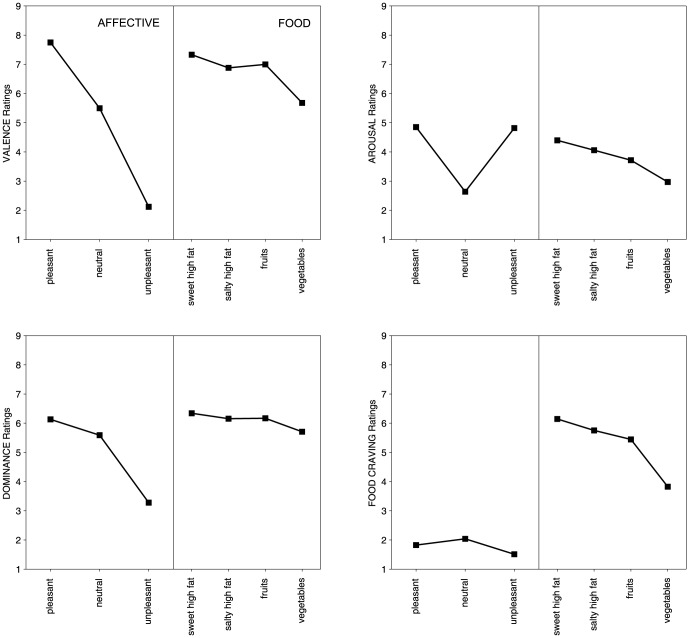
Valence, Arousal, Dominance, and Food Craving ratings across picture categories.Evaluative judgments of valence (panel a, top left), arousal (panel b, top right), dominance (panel c, bottom left), and food craving (panel d, bottom right) for affective and food picture categories. In each panel, affective categories (with pictures taken from the International Affective Picture System) are on the left, while food categories from the OLAF are on the right.